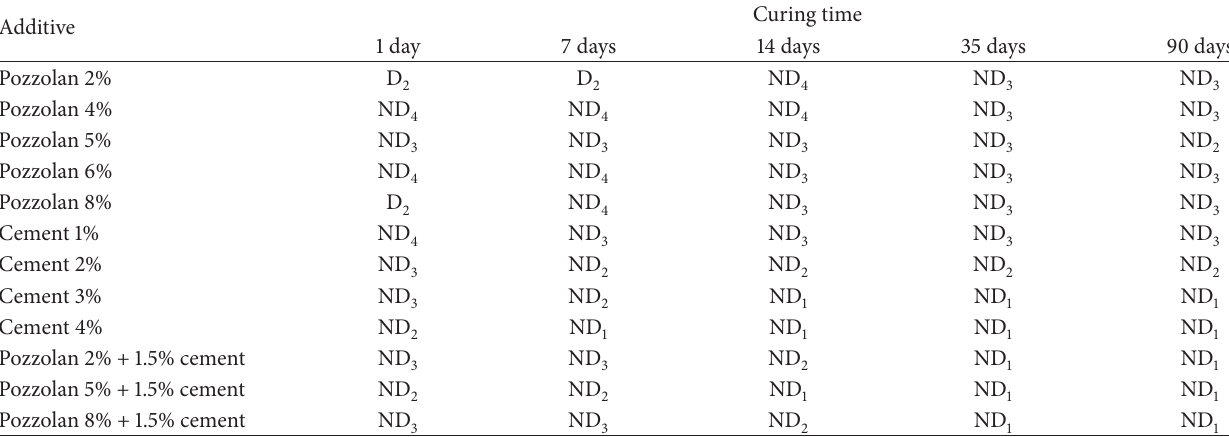
Table 3: Categorization based on pinhole test results of clay sample stabilized with pozzolan alone, cement alone, and pozzolan plus 1.5 percent cement.